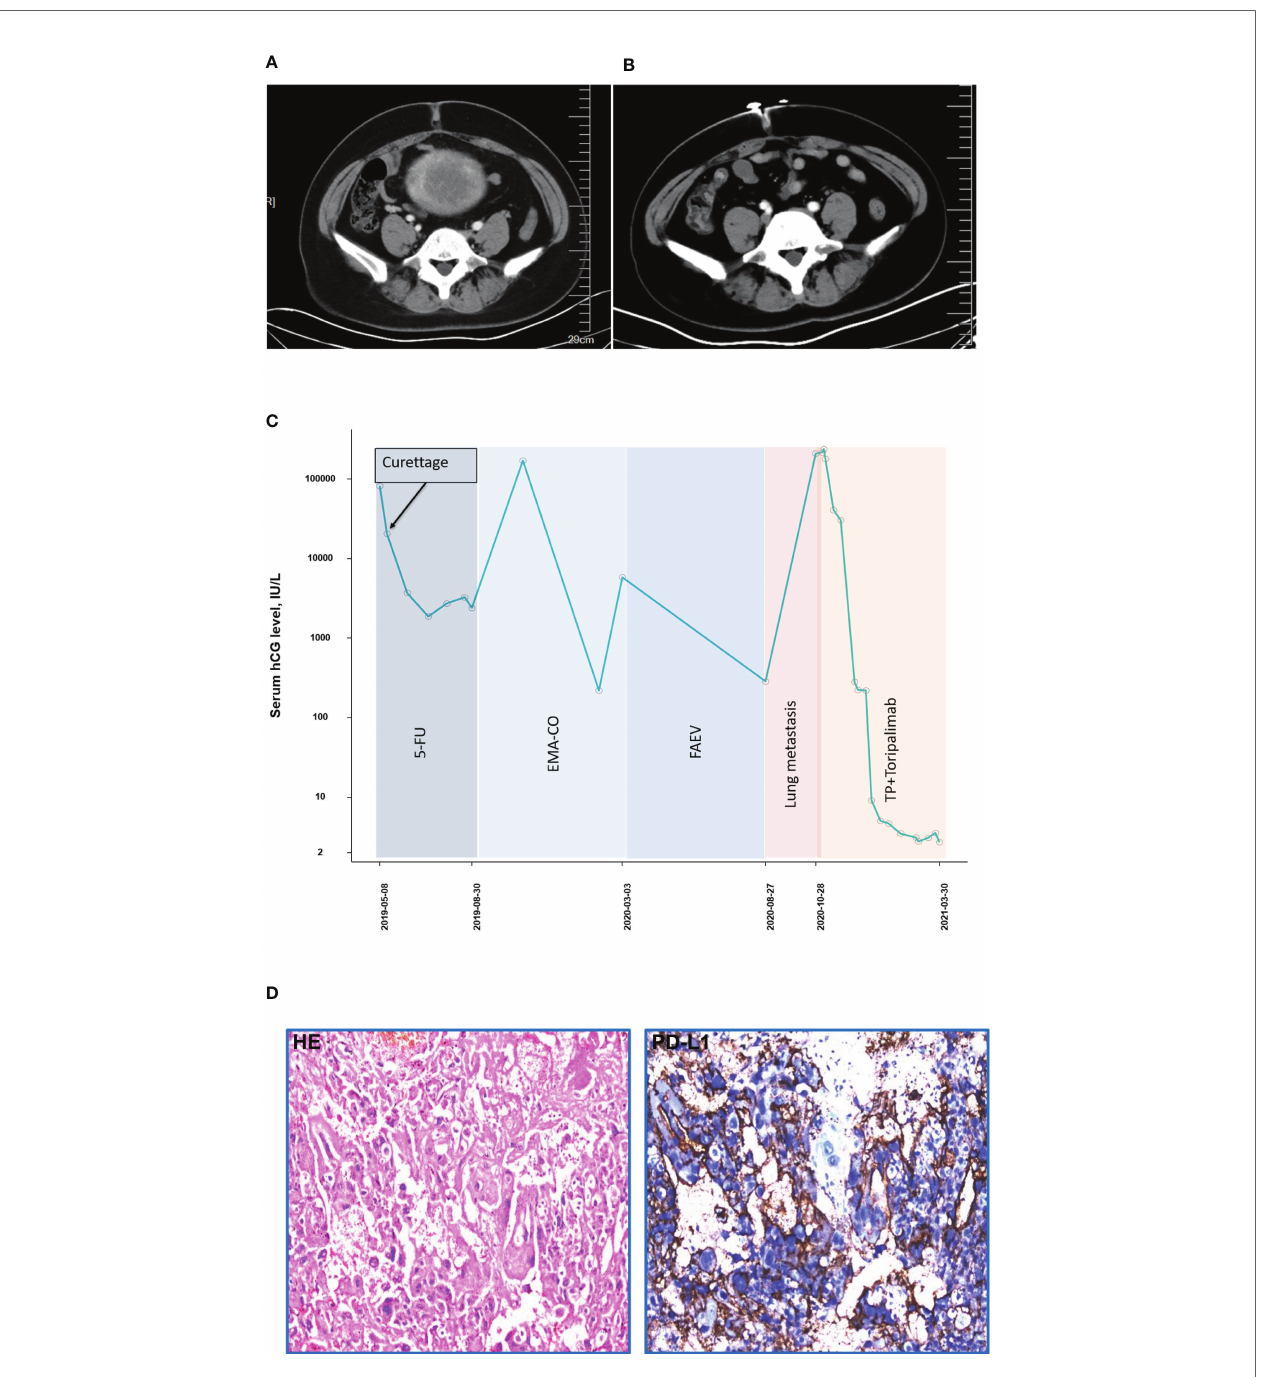
FIGURE 4 | Computed tomography imaging (A) before combined treatment of PD-1 and chemotherapies (B) after combined treatment of PD-1 and chemotherapies (patient 4). (C) The concentration of the b -hcg level since the diagnosis of choriocarcinoma (patient 4). (D) Immunohistochemistry of PD-L1 expression (patient